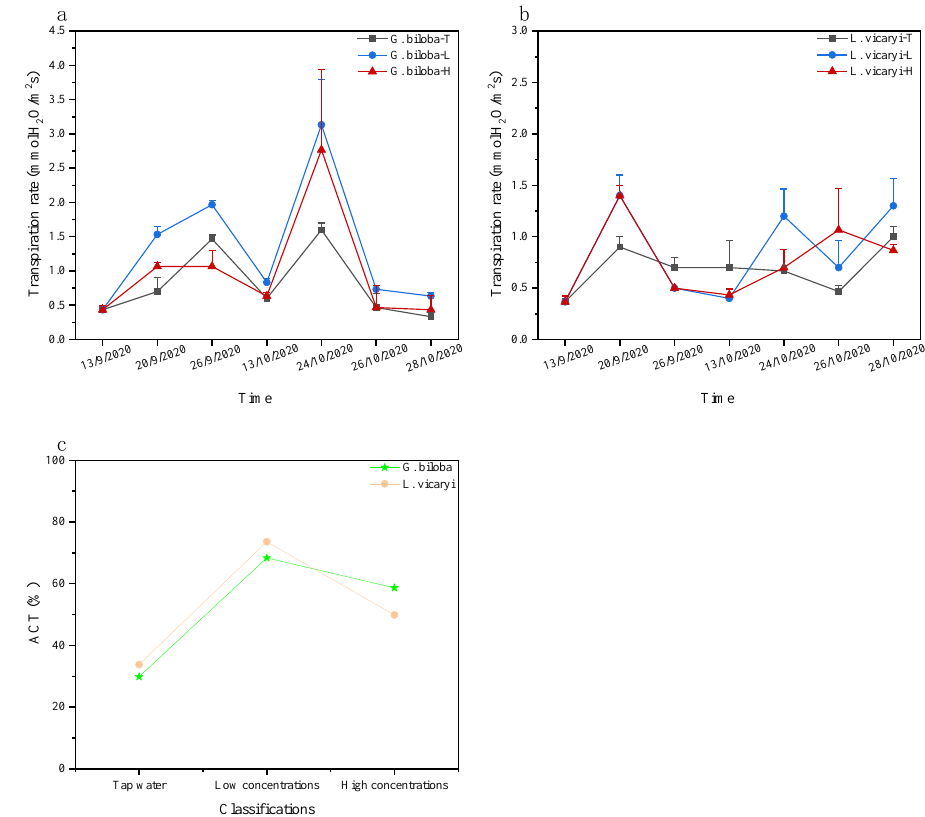
Figure 6. Changes in the ( a ) Ginkgo biloba L. and ( b ) Ligustrum × vicaryi transpiration rates; error bar represented the measurement error of n leaf physiological index of the same plant, n = 3; and ( c ) ACT for the plant transpiration